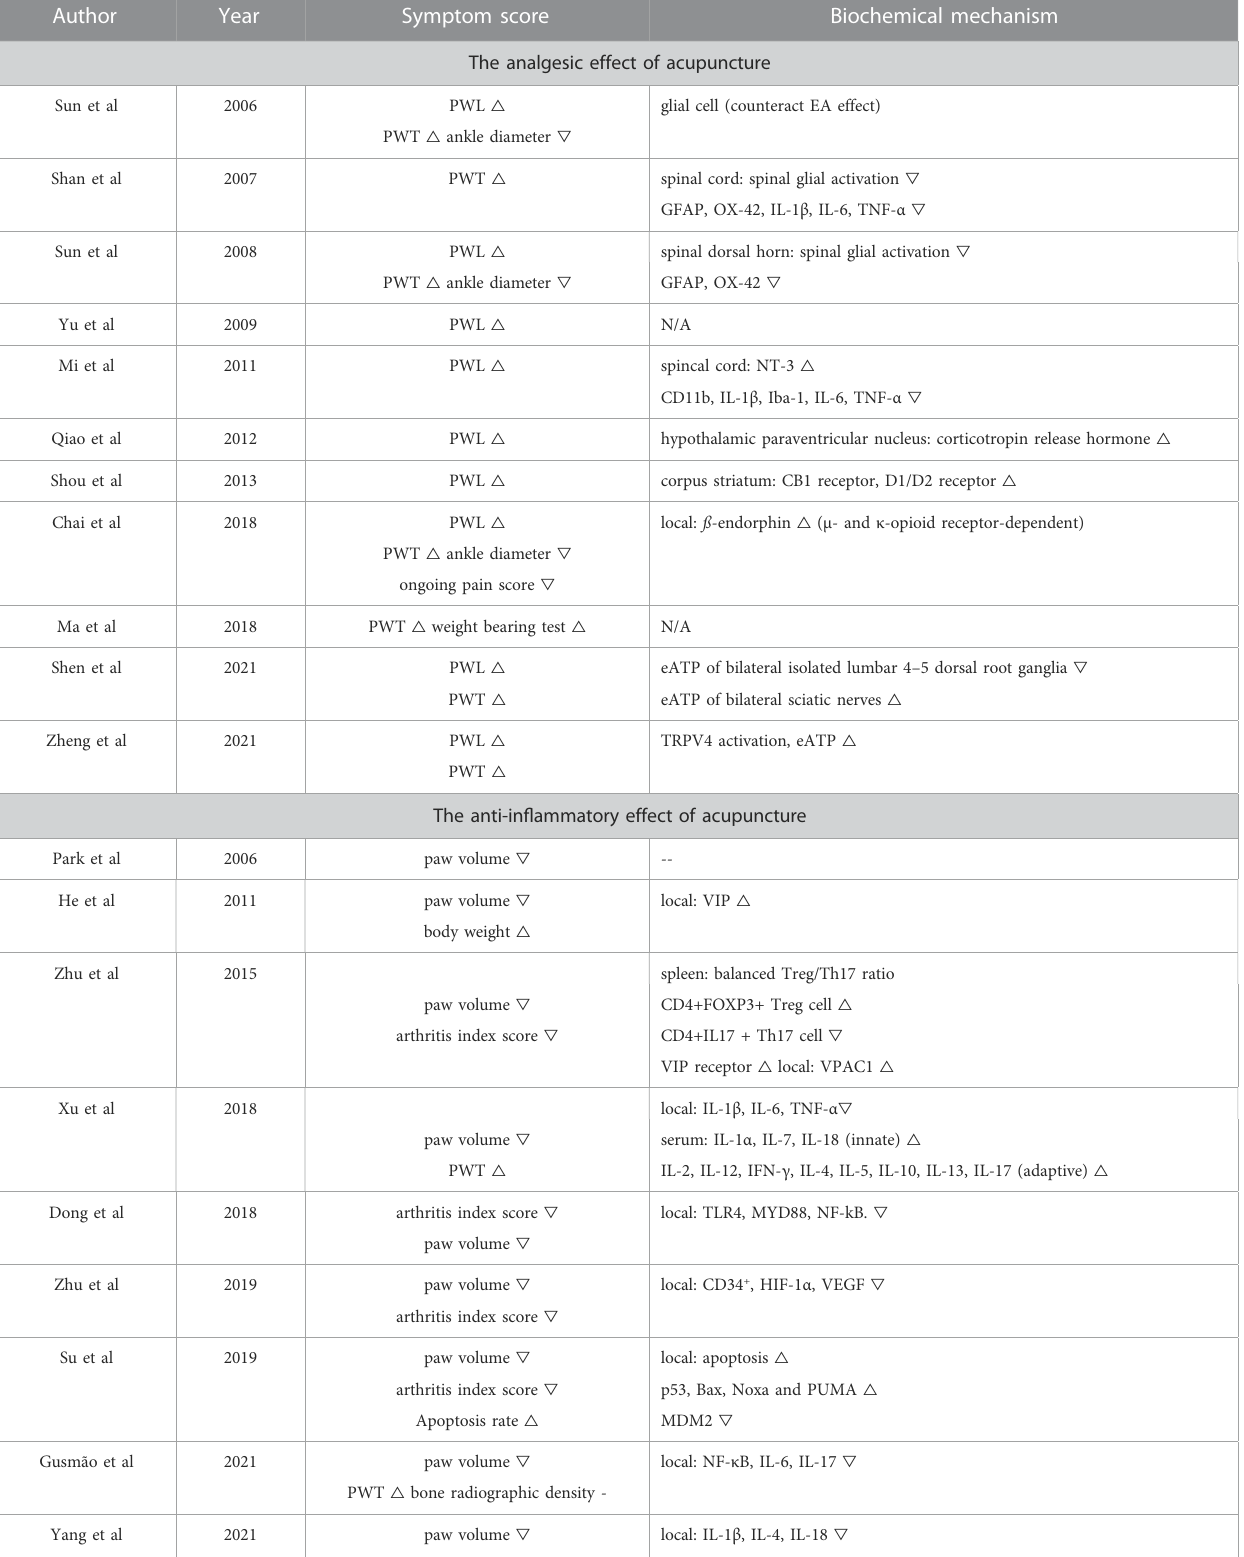
TABLE 2 Symptom score change by acupuncture treatment and the underlying mechanisms.